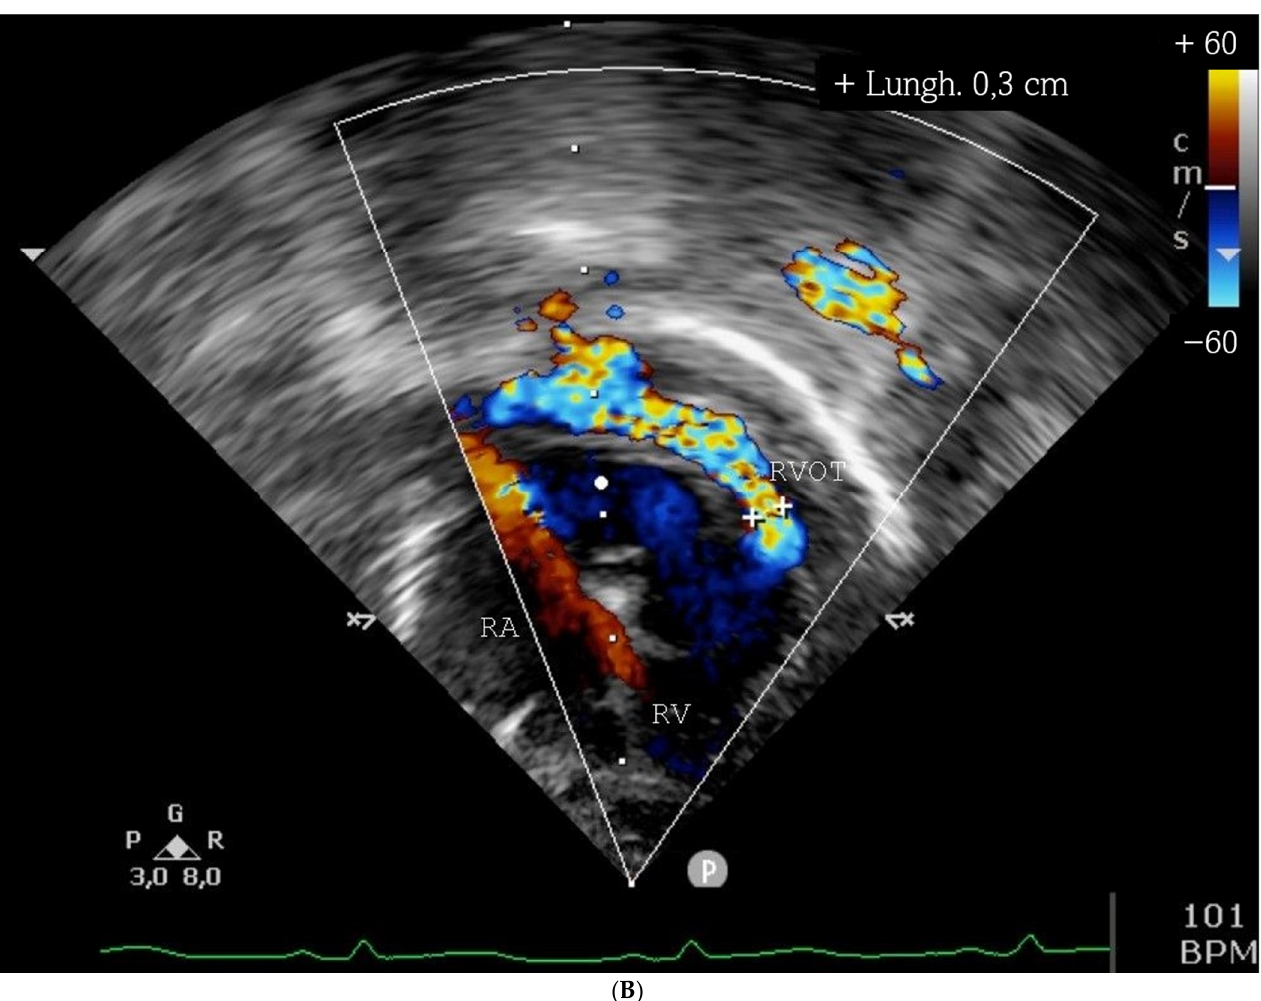
Figure 1. ( A ) Echocardiographic picture in subcostal right oblique view showing TOF anatomy with a long, very narrow right ventricular infundibulum. ( B ) Significant aliasing is imaged at the color-Doppler analysis. Abbreviations: RA = right atrium; RV = right ventricle; RVOT = right ventricular outflow tract.